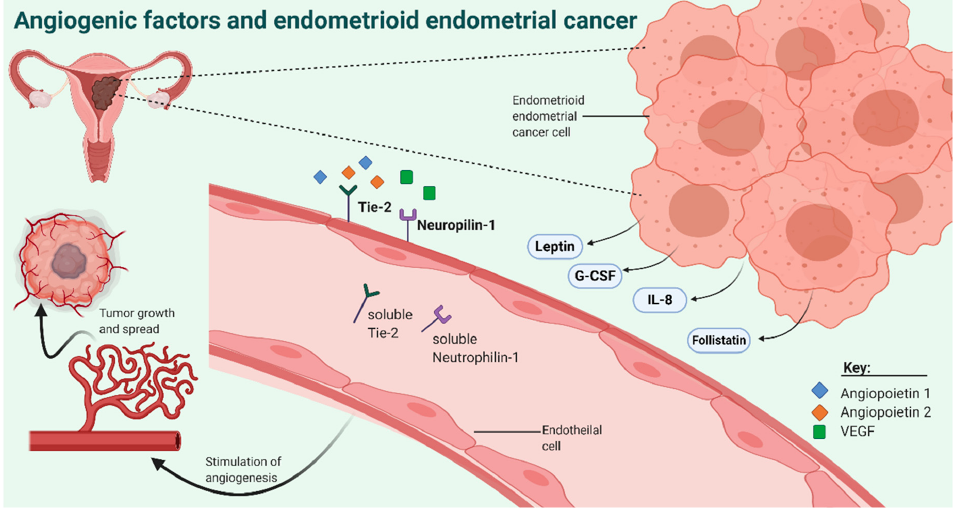
Figure 1. The angiogenic factors involved in the pathology of endometrioid EC. Created with Bio- Render.com.